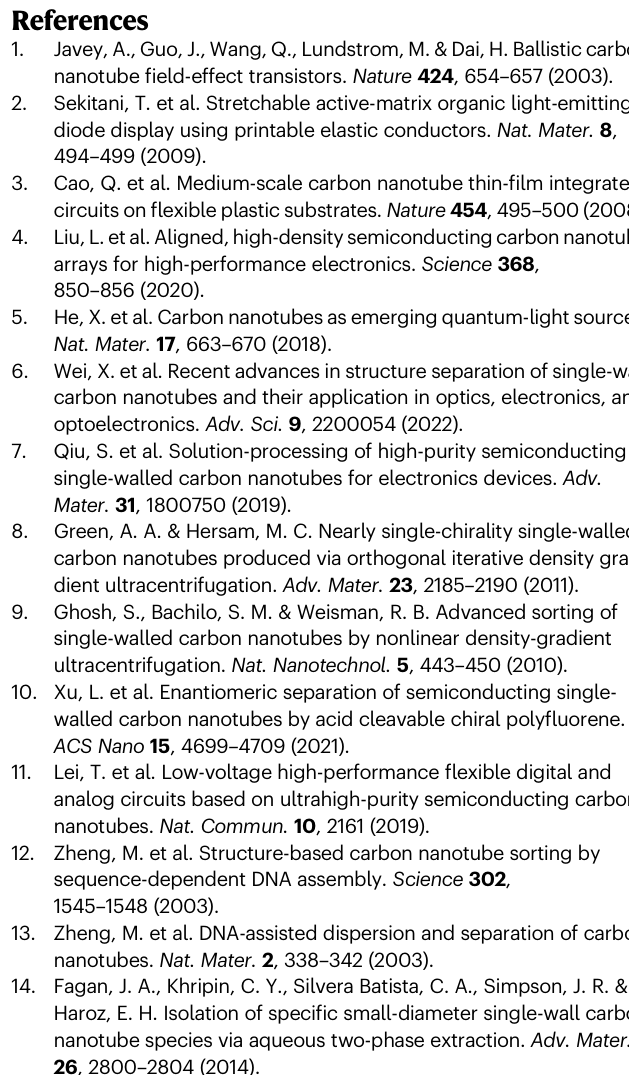
Fig. 6 | Potential and challenge analysis for industrialization and commercia- lization of the current technique. a Life cycle greenhouse gas emissions, b cumulative energy demand, and c cost of producing 1-mg single-chirality